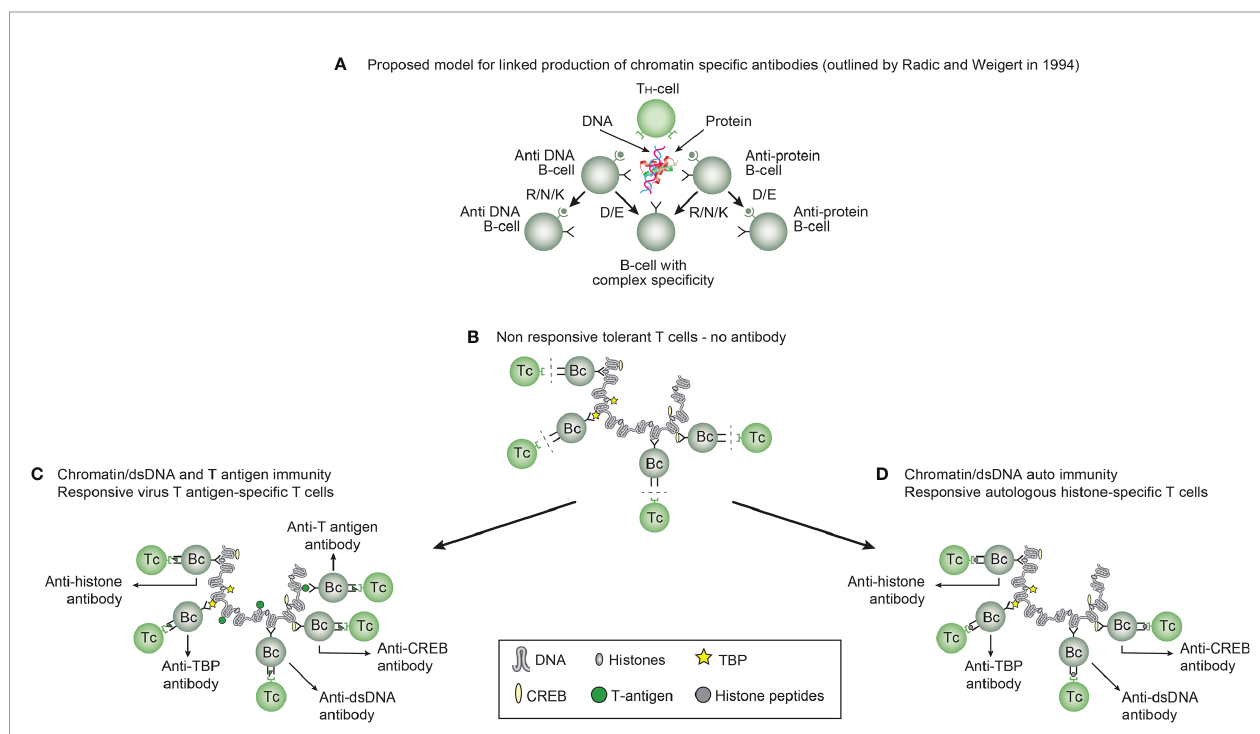
TABLE 2 | Central scientists and the resolution of the DNA structure. Miesher et al. (42, 43) (cid:129) Described in 1871 Nuclein later known as DNA. Levene et al. (44, 45) (cid:129) Discovered ribose in 1909 and deoxyribose in 1929. (cid:129) Suggested the structure of nucleic acids as a repeating nucleotide tetramer. (cid:129) DNA contained adenine, guanine, thymine, cytosine, deoxyribose, phosphate group. Chargaff et al. (46 – 48) De fi ned in 1950, 1952 the 2 Chargaff rules (cid:129) In double-stranded DNA, guanine units is equal to cytosine units, adenine units is equal to thymine units. (cid:129) The composition of DNA varies between species. Franklin et al. (49 – 51) (cid:129) In 1952 Franklin produced high-resolution photographs of crystallized DNA fi bers, interpreted as a helical structure. She and Chargaff were close to de fi ning the structure of DNA. (cid:129) Franklin described the A and B forms of DNA.